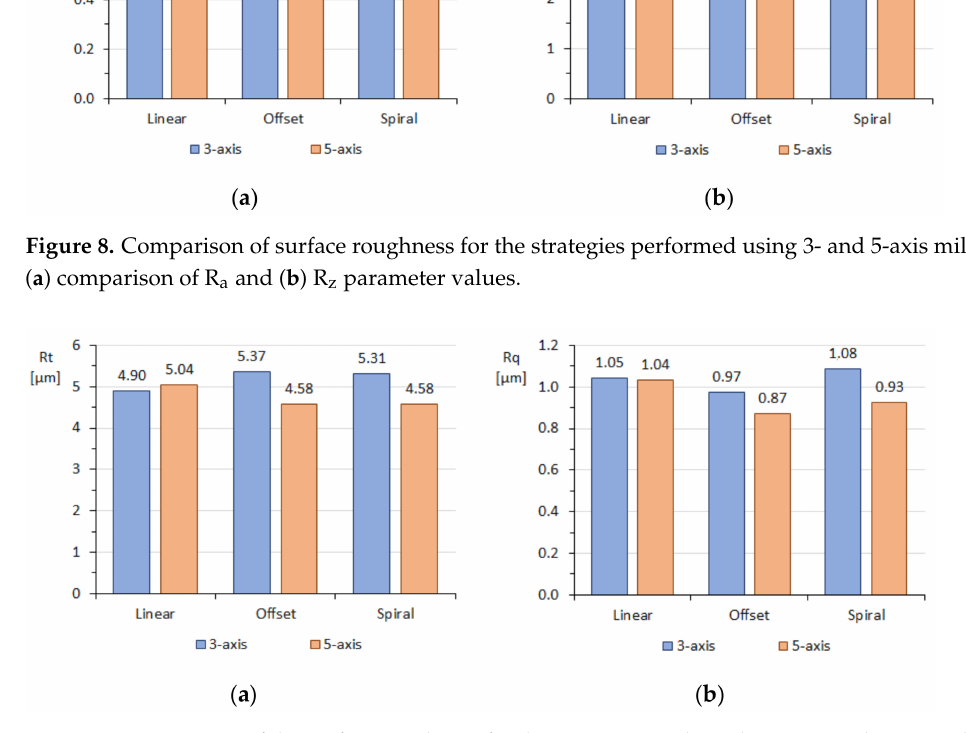
Figure 9. Comparison of the surface roughness for the strategies evaluated using 3- and 5-axis milling: ( a ) comparison of R t and ( b ) R q parameter